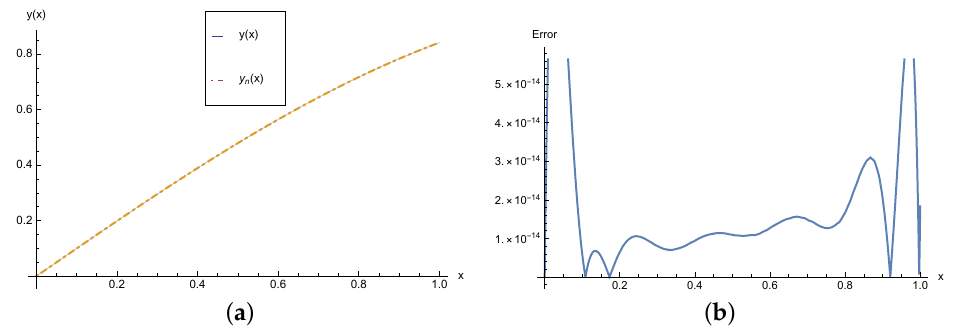
Figure 3. ( a ) Comparison between the solutions—( b ) error function for n = 10. Table 7. Applying the FPA for Example 1 with (cid:101) = 10 − 6 .